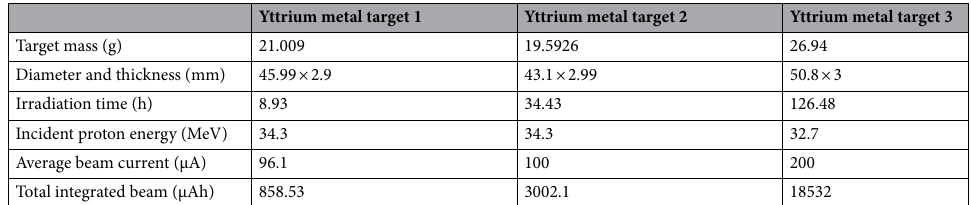
Table 2. Yttrium metal targets and irradiation